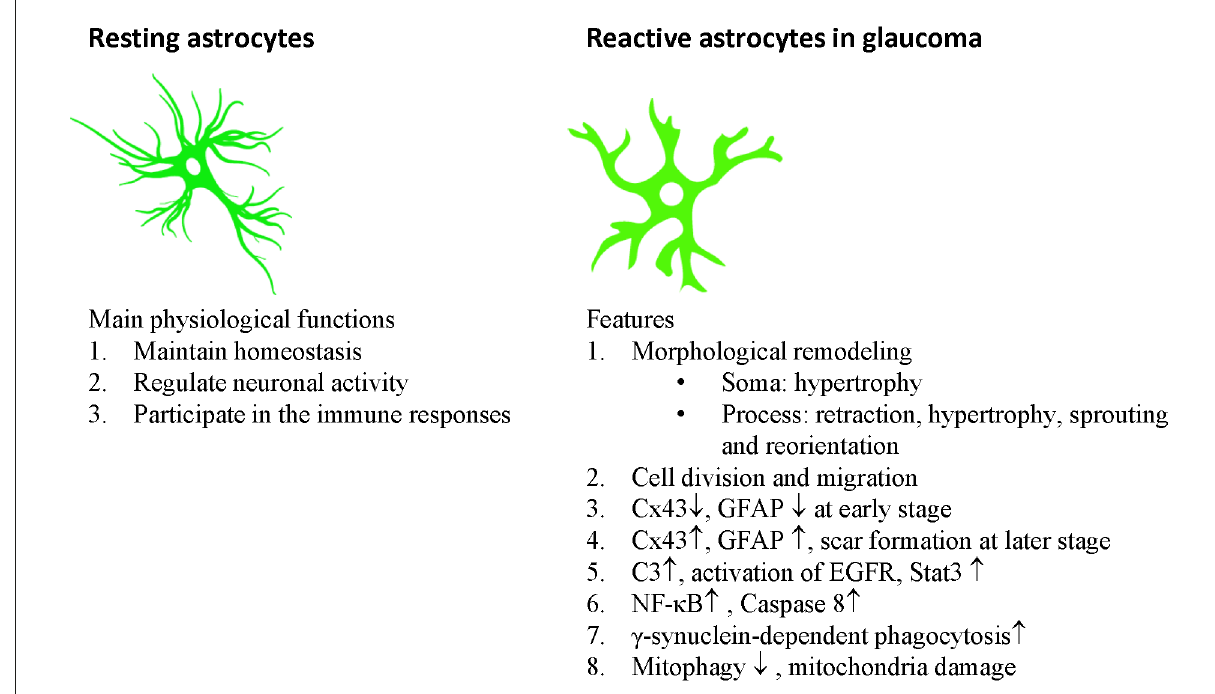
FIGURE2 Main physiological functions of astrocytes and features of reactive astrocytes in